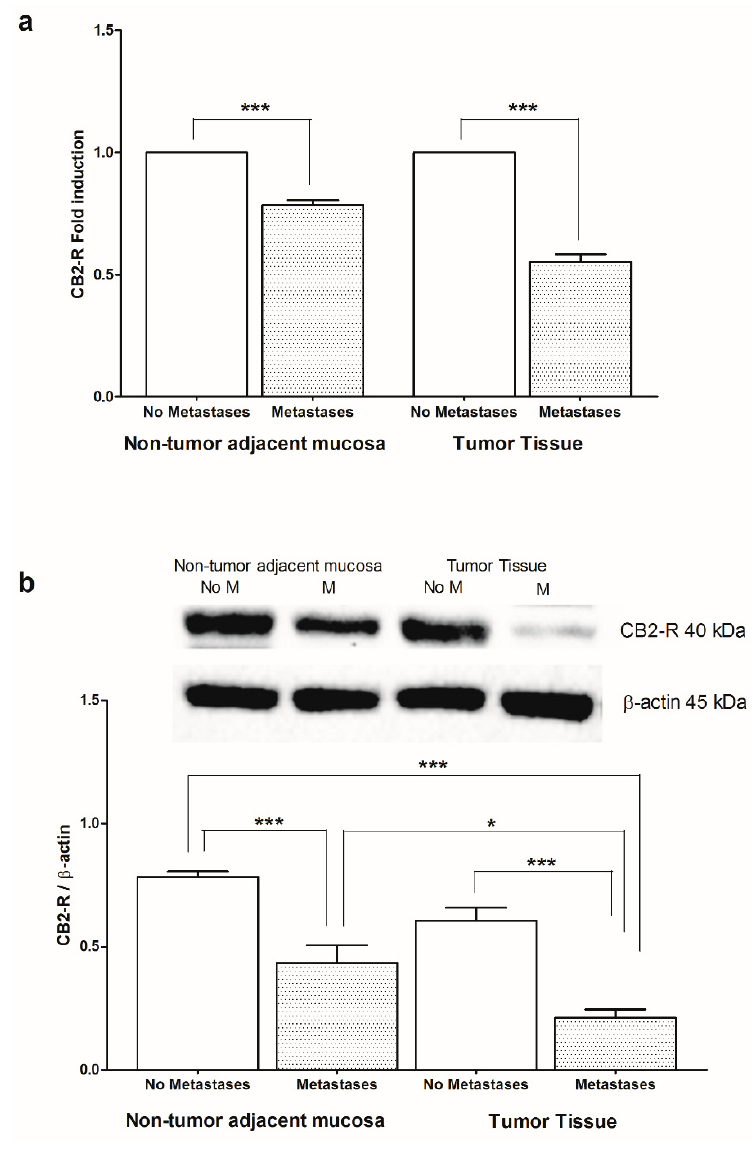
Figure 5. ( a ) Cannabinoid receptor 2 (CB2-R) mRNA levels in non-tumor adjacent mucosa and tumor tissue from colorectal cancer patients with and without metastases. Data are expressed as Fold induction. *** p < 0.005 (Student’s t -test). ( b ) Western blotting analysis of CB2-R protein in the same patients. Representative blots are also shown (No M = No Metastases; M = Metastases). * p < 0.05, *** p < 0.005 (ANOVA and Tukey’s multiple comparison test).